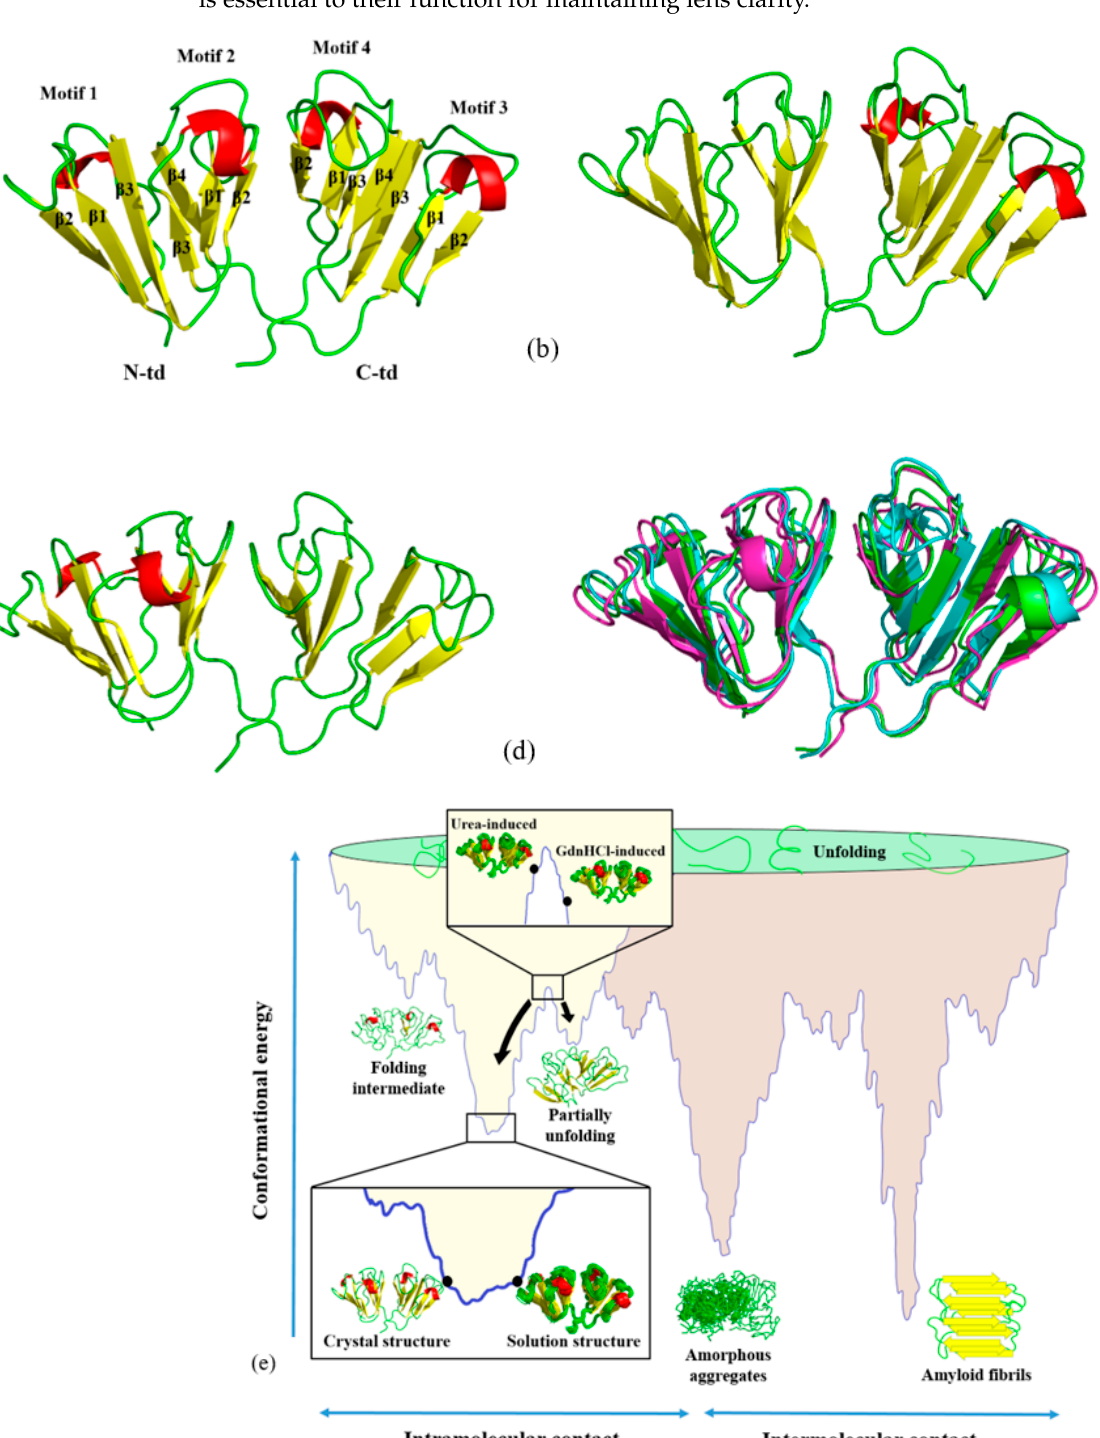
Figure 1. NMR solution structures of HGDC ( a ) without denaturant, ( b ) with 5.0 M urea, and ( c ) with 1.0 M GdnHCl. ( d ) Superimposition of the solution structures of HGDC with and without de- naturants. The solution structures of HGDC without denaturant, with 5.0 M urea, and with 1.0 M GdnHCl were presented in green, cyan, and magenta, respectively. ( e ) A hypothetical conformational poten- tial energy surface showing relative positions of the different HGDC conformational states. This schematic diagram is adapted from Fig. 1 of Jahn and Radford (2005)